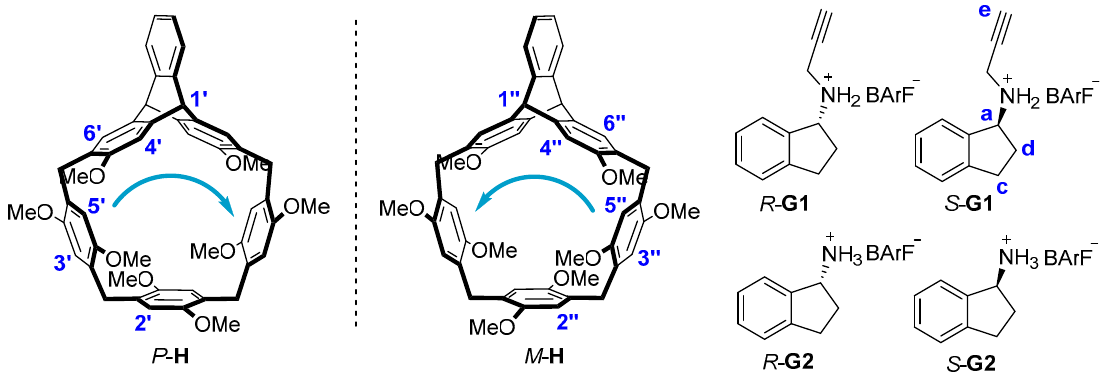
Figure 1. Structures and proton designations of the hosts ( P - H / M - H ) and the guests ( R - G1 / S - G1 and R - G2 / S - G2 ).